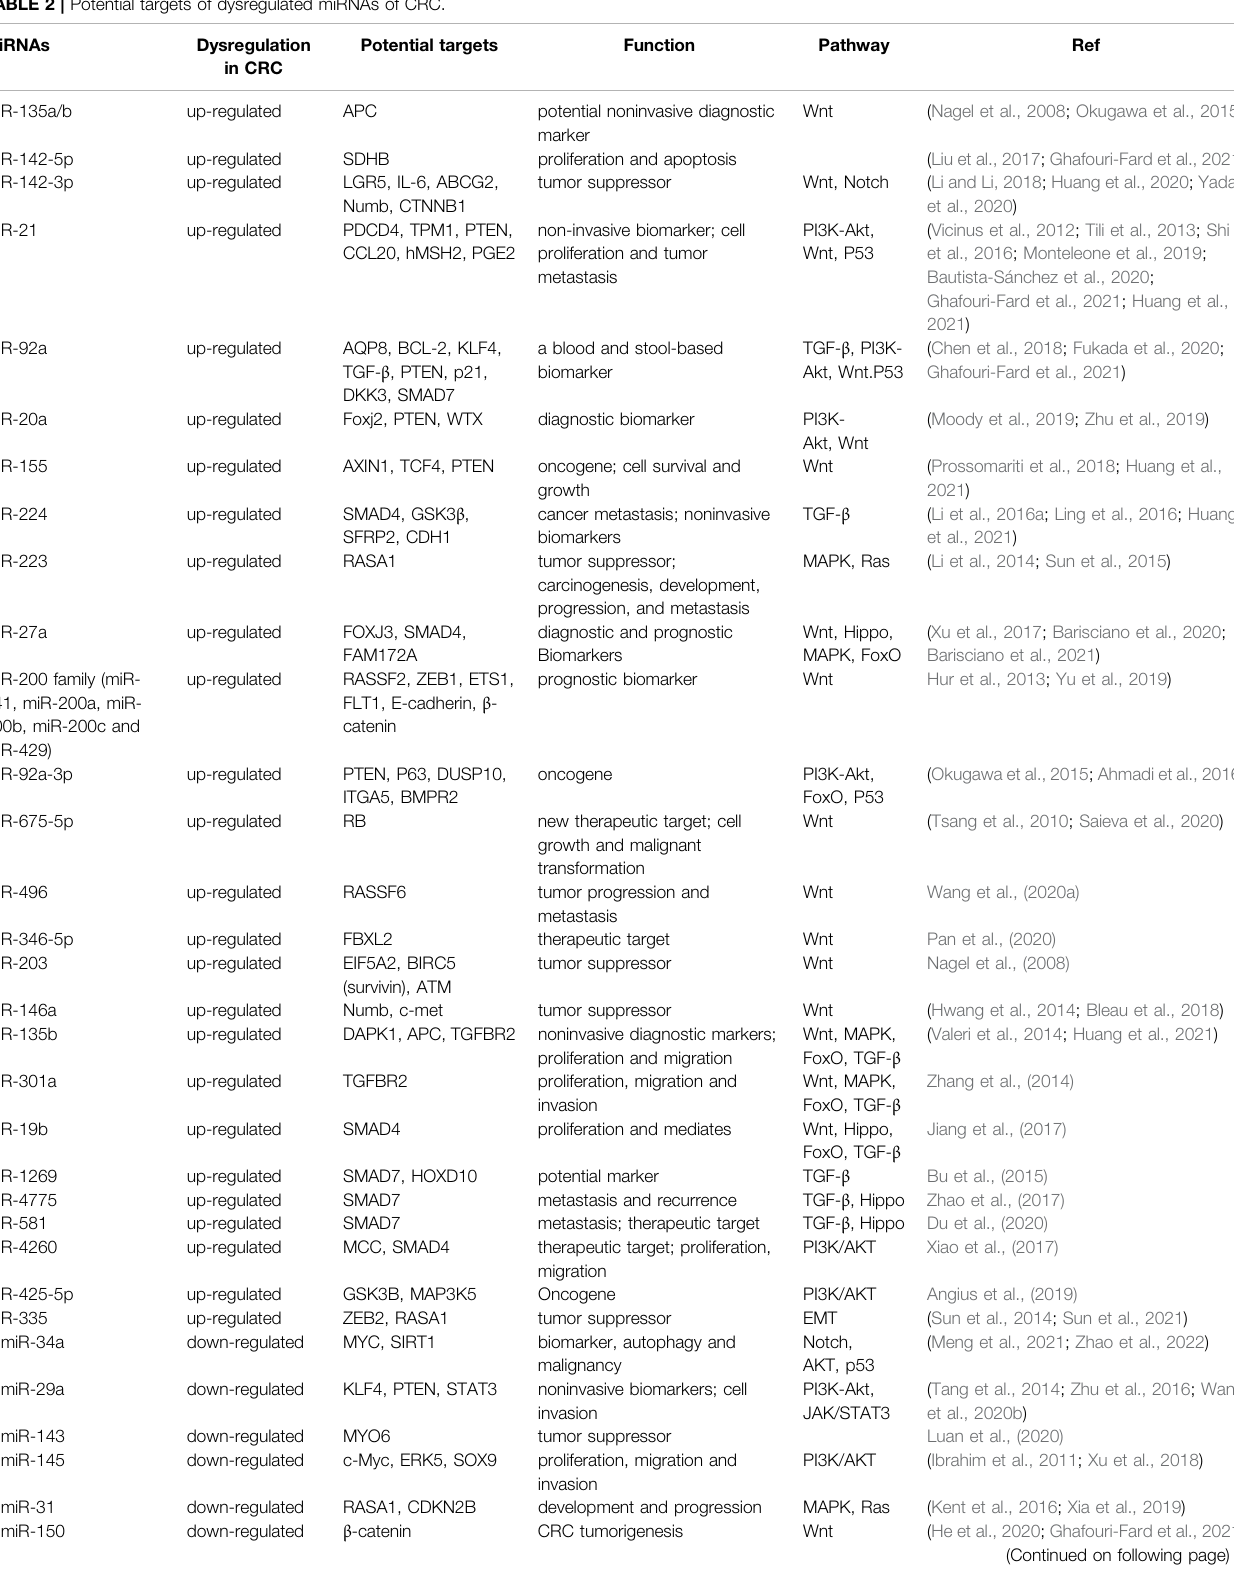
TABLE 2 | Potential targets of dysregulated miRNAs of